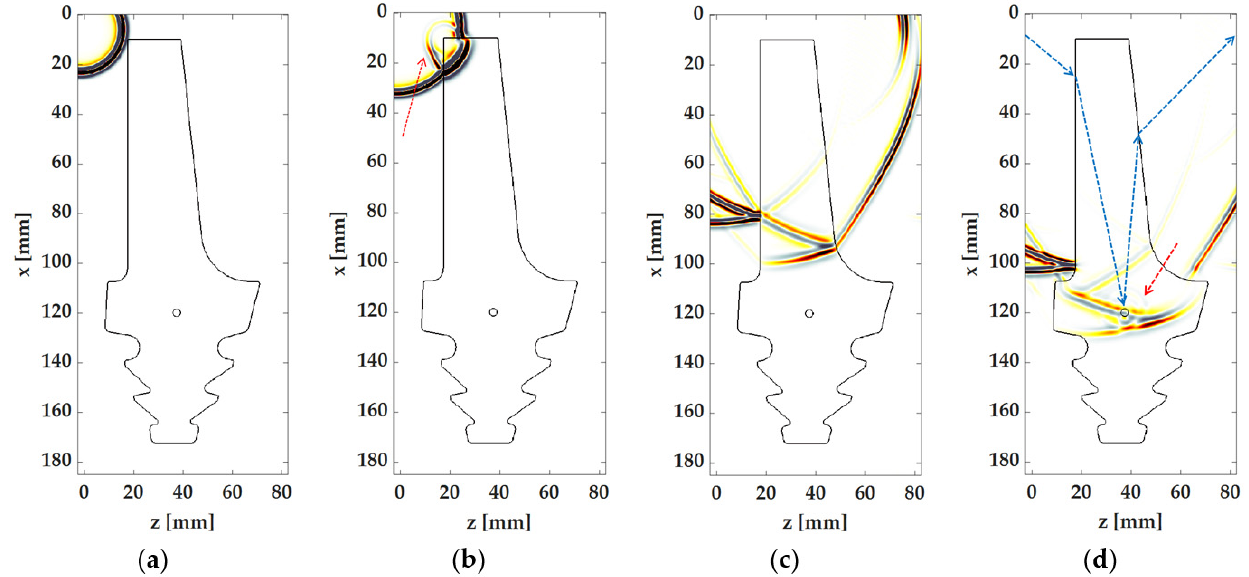
Figure 5. Ultrasonic wave propagation excited with the 1 st transducer at different time slots: ( a ) t = 6 µ s; ( b ) = 8 µ s; ( c ) = 21 µ s; ( d ) = 26 µ s.